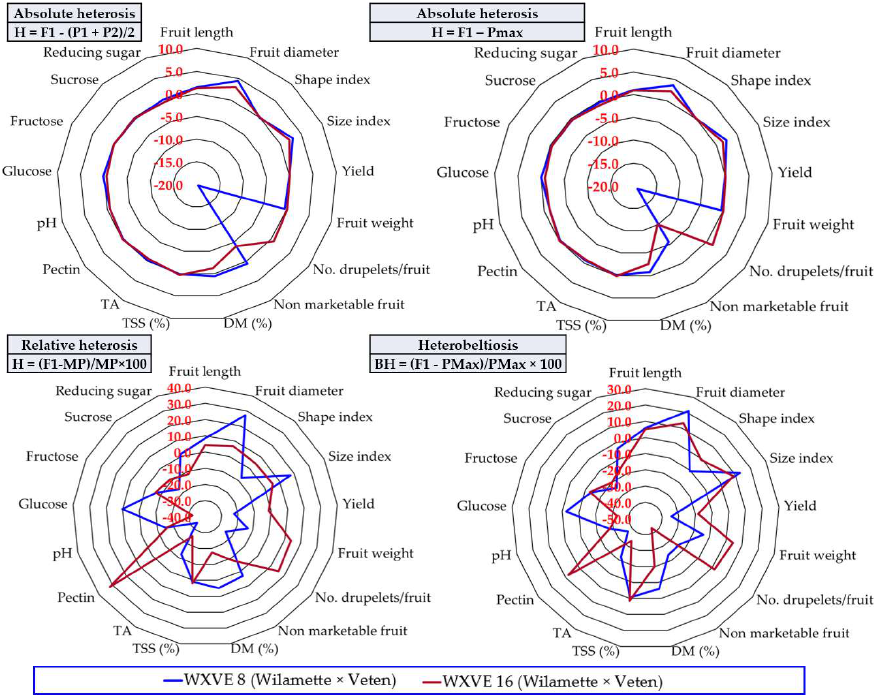
Figure 8. The heterosis effect upon the 17 analyzed characteristics in two promising selections obtained from the hybridization of Willamette × Veten.